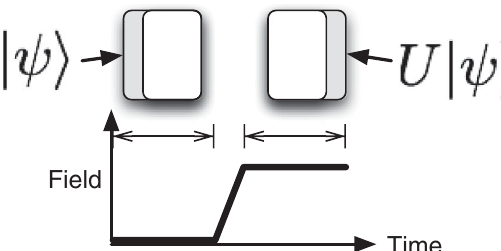
FIG. 2. Sketch of how an adiabatic quantum transistor be- haves. With no applied field, the quantum information is on one side of the device (shaded grey, left), and after the adiabatic application of the field, the quantum information has propagated to the other side of the device (shaded grey, right) with a unitary U applied to the original information. The strength of the applied field is initially zero and then is ramped up to a nonzero value, during which time the quantum information is not localized to either end of the